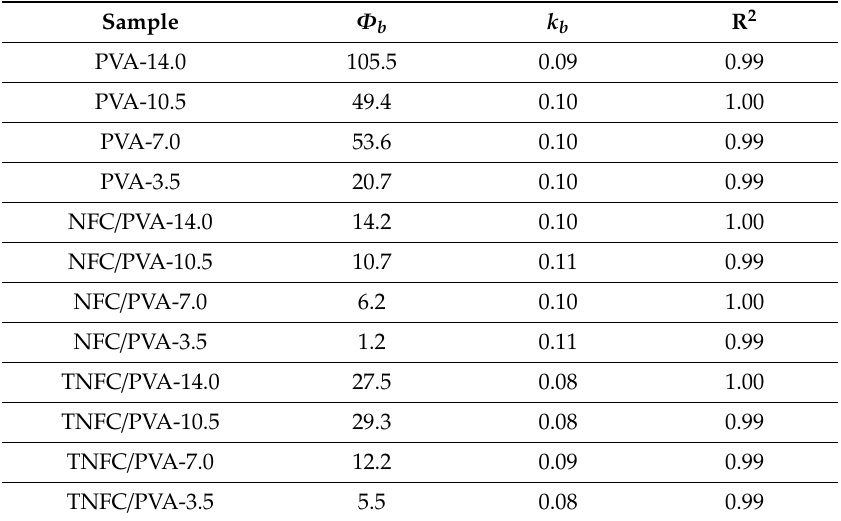
NFC / PVA-14.0 NFC / PVA-10.5 NFC /